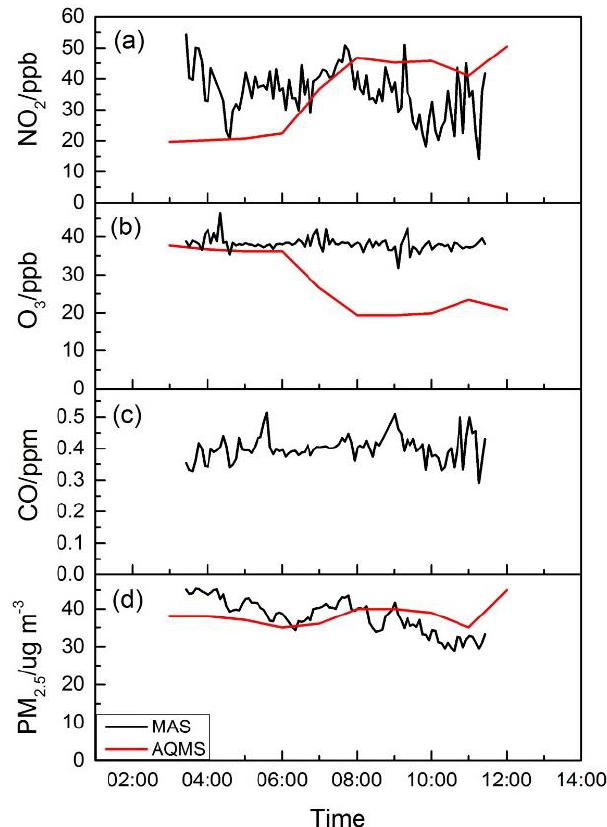
Figure 9. The pollutants’ concentrations before, during and after the Marathon at SSP from MAS and at Sham Shui Po AQMS. CO is not reported by the Sham Shui Po AQMS site. ( a ) Time series for NO 2 ; ( b ) time series for O 3 ; ( c ) time series for CO; ( d ) time series for PM 2.5 .